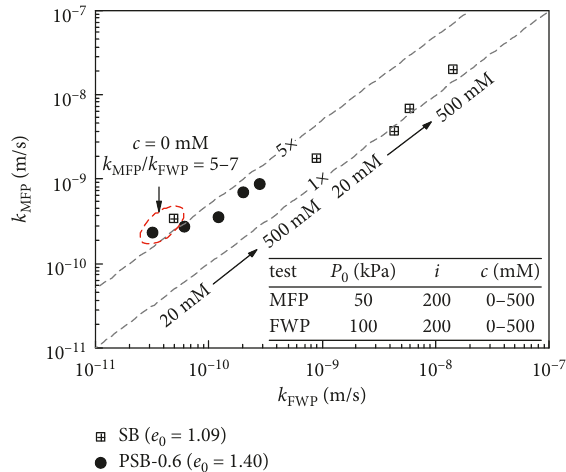
Figure 12: Comparison of hydraulic conductivity calculated from modified filter press tests ( k MFP ) and measured by flexible-wall permeability tests ( k FWP